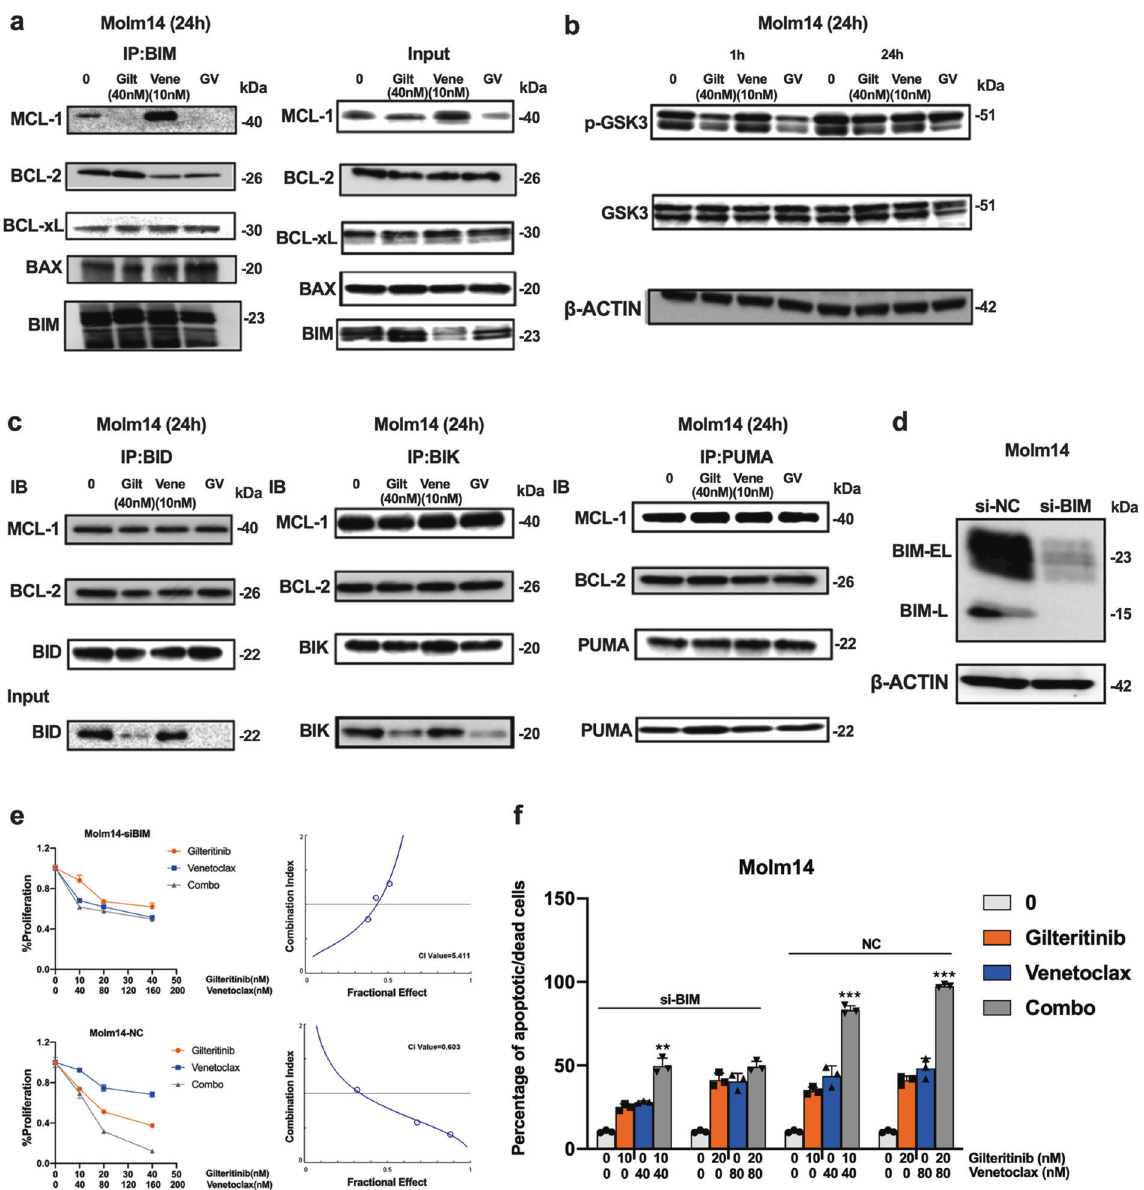
Fig. 5 Gilteritinib and Venetoclax combined treatment releases BIM from the pro-survival proteins BCL-2 and MCL-1 to trigger apoptosis/cell death. a Co-immunoprecipitation followed by western blot analysis for BIM binding proteins after 24 h of treatment with Gilteritinib and/or Venetoclax. b Western blot analysis for p-GSK3 and GSK3 expression in Molm14 cells treated for 1 h and 24 h. c Co-immunoprecipitation analysis for BID, BIK, and PUMA binding proteins after 24 h treatment. Input levels of the immunoprecipitated proteins are shown below. d Western blot analysis for BIM protein in negative control (si-NC) and si-BIM group. e 48 h MTT and f 48 h apoptosis analysis for Molm14-si-NC and Molm14-si-BIM cells treated with Gilteritinib and Venetoclax at the indicated